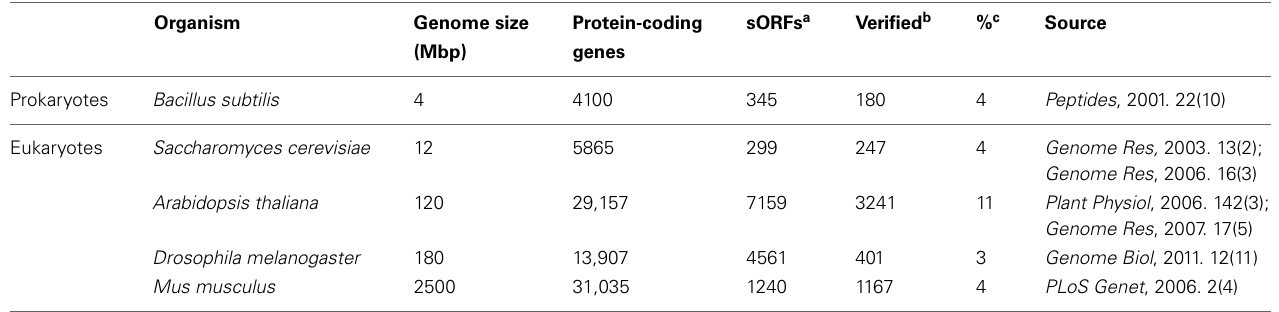
Table 2 | Summary of large-scale sORF studies in different